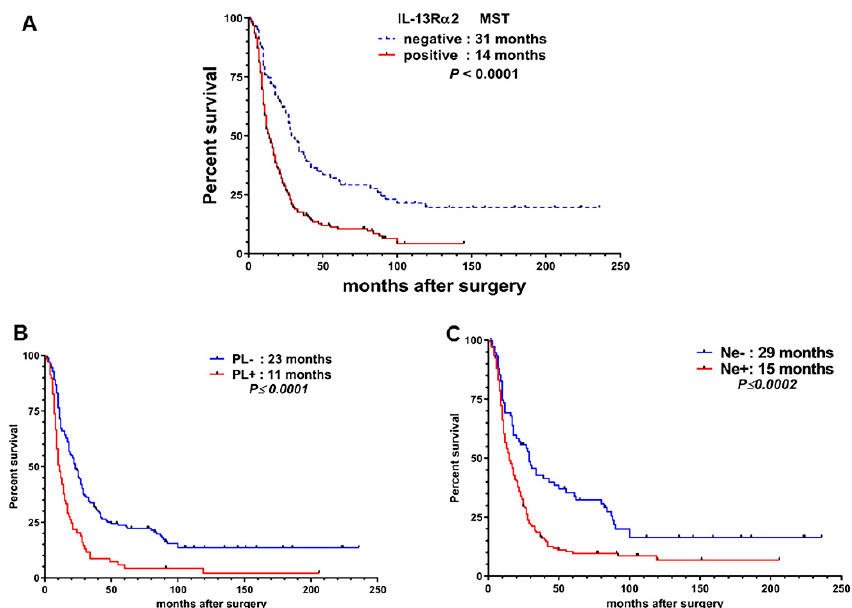
Figure 3. Kaplan–Meier survival curve of patients after pancreatic cancer resection. Survivals were compared between patients with ( A ) IL-13R α 2-positive tumors and IL-13R α 2-negative tumors, ( B ) PL– and PL + and, ( C ) Ne– and Ne + tumors.